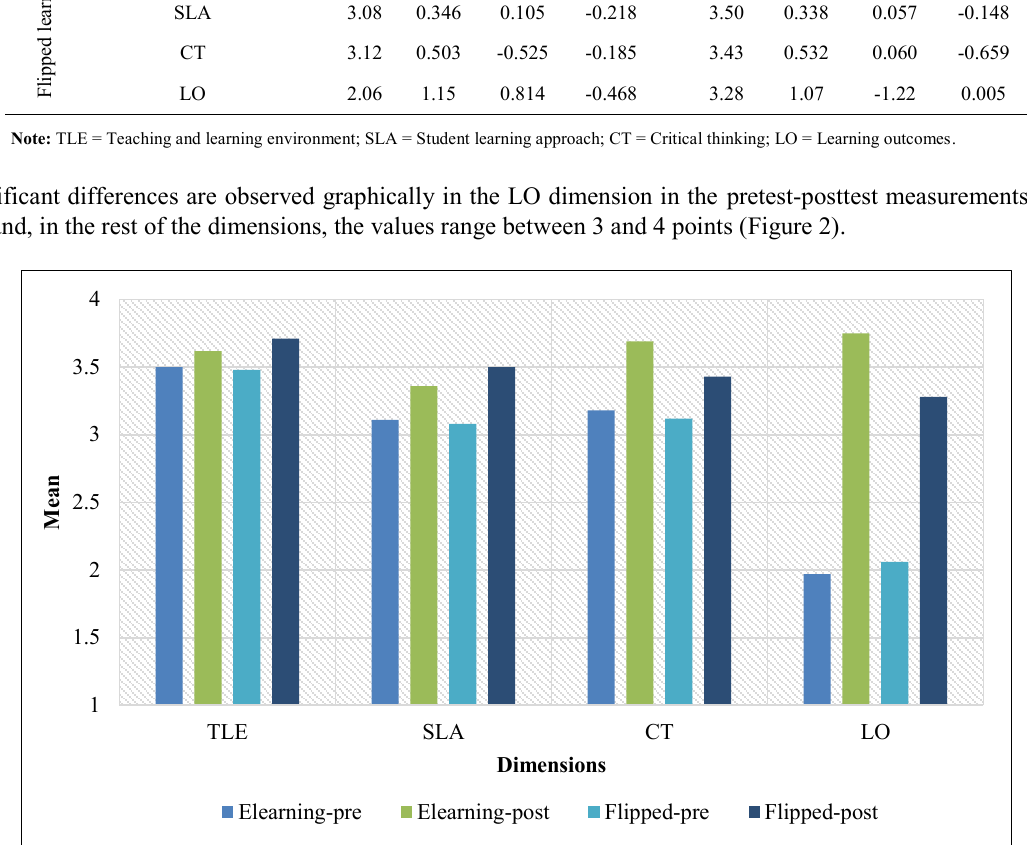
Figure 2. Comparison between e-learning and flipped learning group